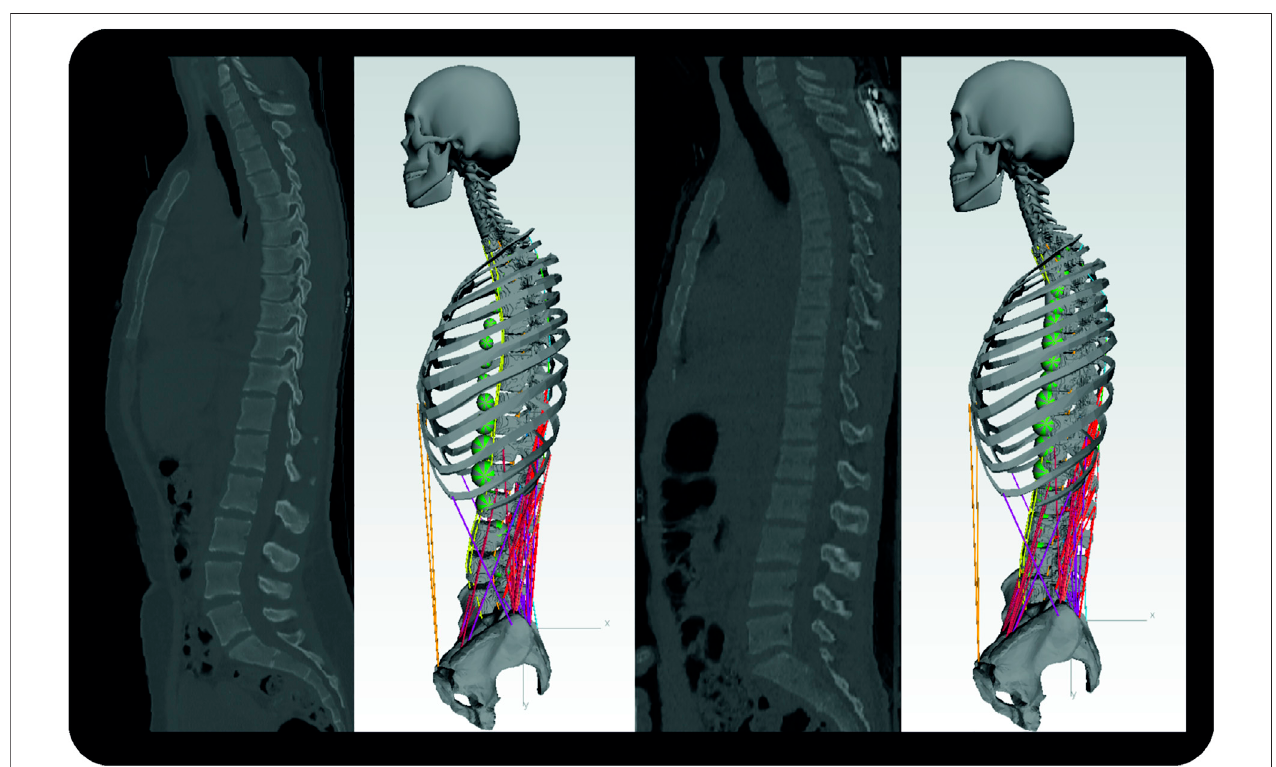
FIGURE 6 | Sagittal CT images of subject one (left) and subject two with respective MBS models. Segment masses for soft tissues are visualized by the green spheres. For the sake of clarity, the dummy bodies for the arms are not shown here.